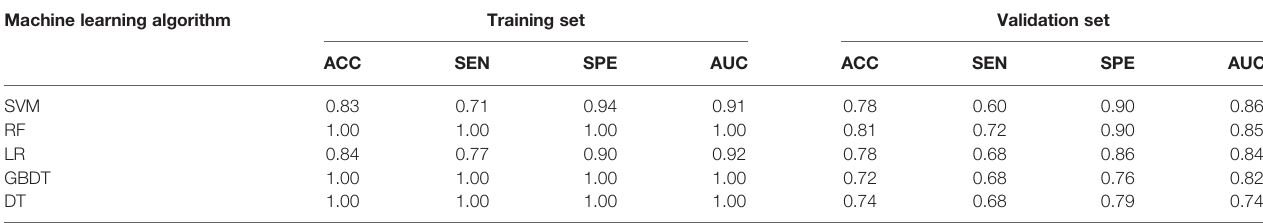
TABLE 2 | Prediction performance in training and validation sets of fi ve machine learning models. Machine learning